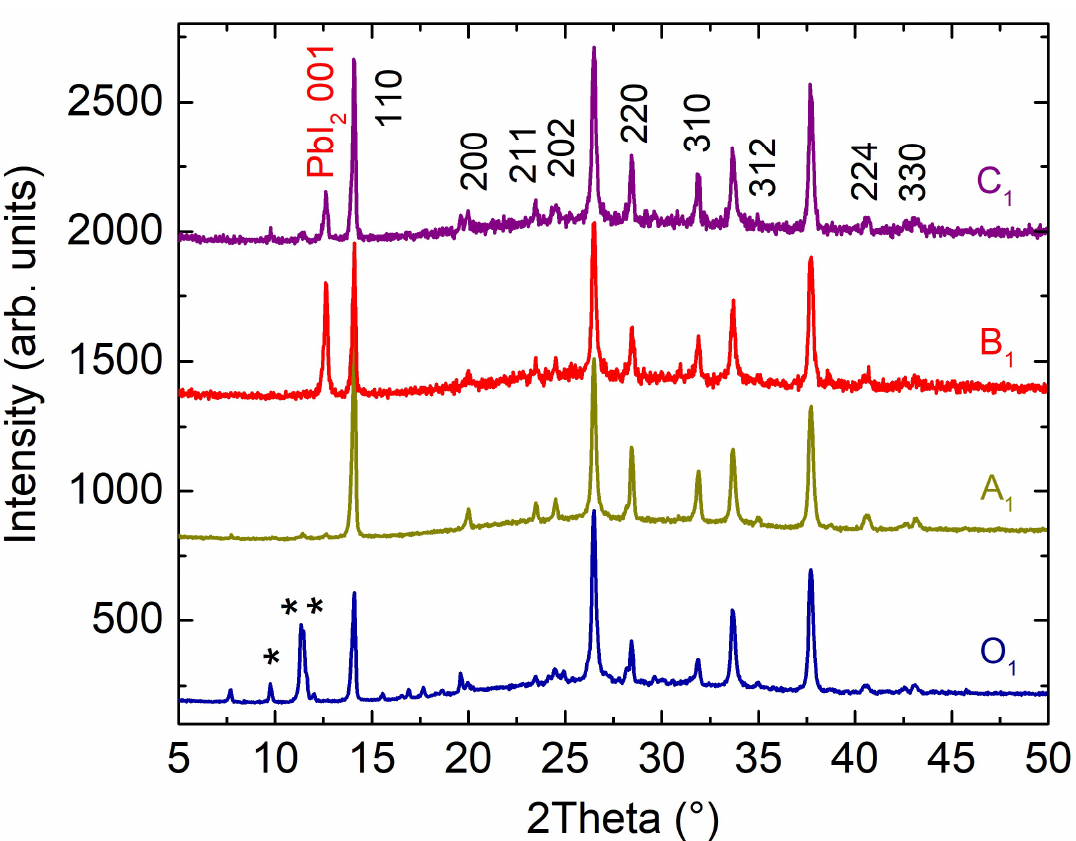
Figure 3. XRD patterns of films O (no acid additive), A (acetic acid), B (formic acid) and C (trifluo- racetic acid), after the first dipping in MAI. The asterisks * and ** for film O 1 correspond to peaks 001 of MAI and (CH 3 NH 3 ) 4 PbI 6 •2H 2 O, respectively, weakly visible for C 1 .